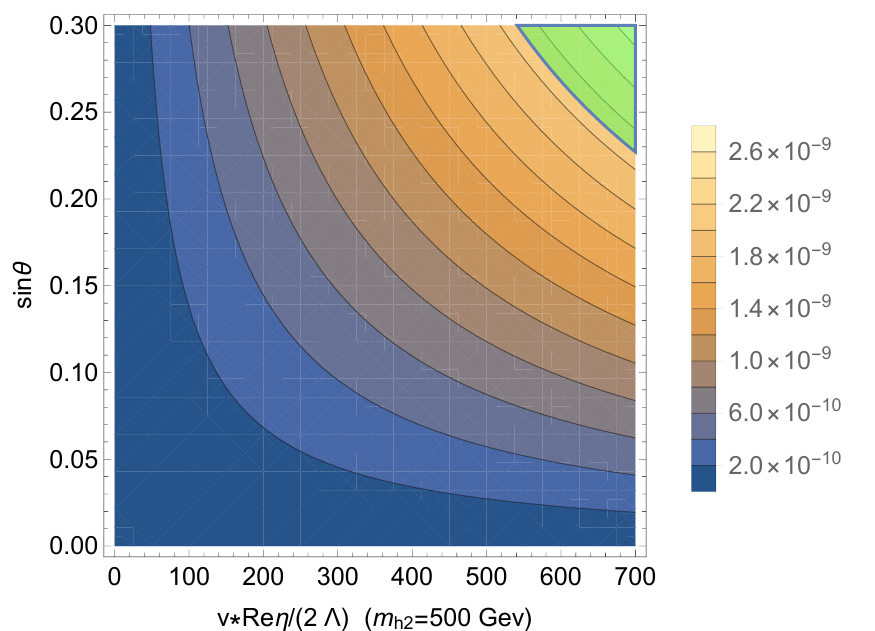
Figure 4 . The contours showing a (cid:22) in the SM+RS model. The green region is where the model produces a (cid:22) within the observed window in eq. (1.2). At (cid:17) = 0, where there is no L CPV , the model does not provide large enough contribution to a (cid:22)